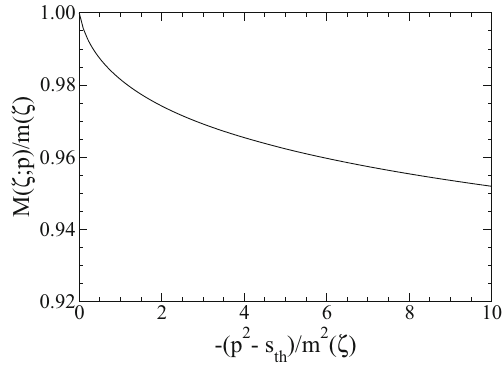
Fig. 4 Theinvariantmass M (ζ ; p ) ,Eq.(87),belowthethreshold s th